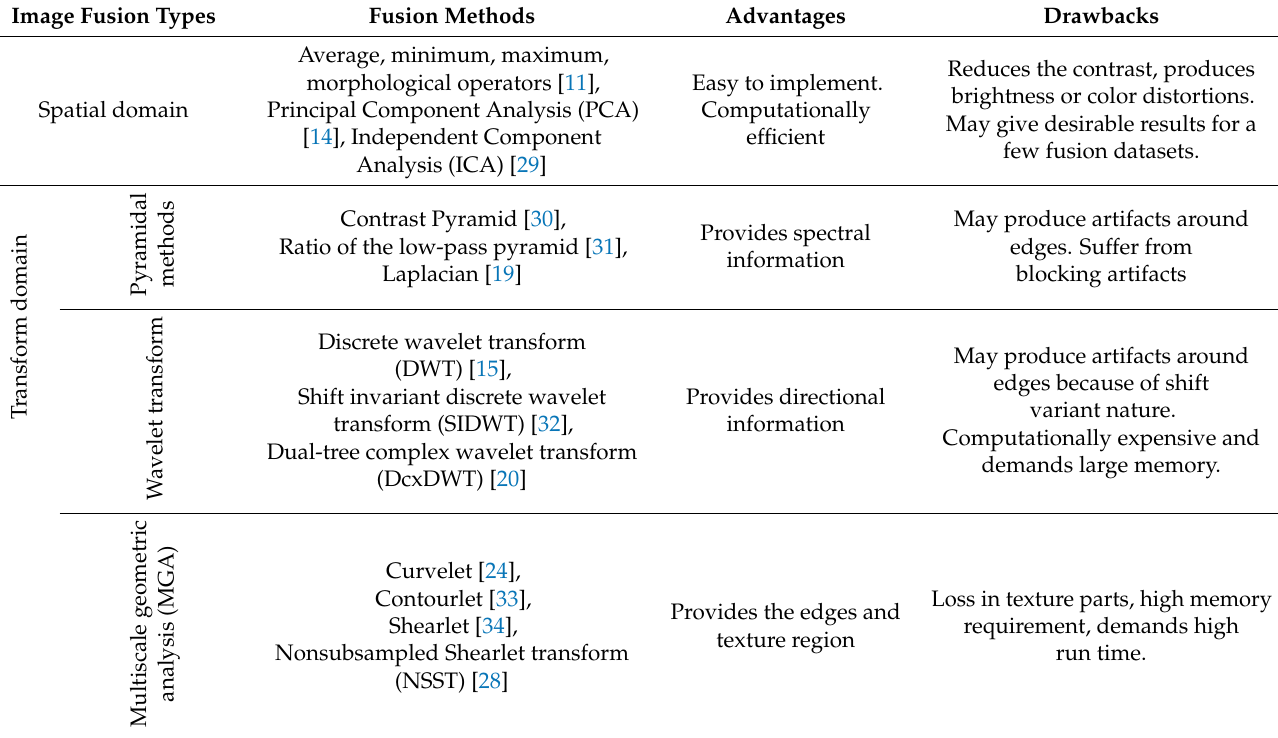
Table 1. Brief summary of the image fusion